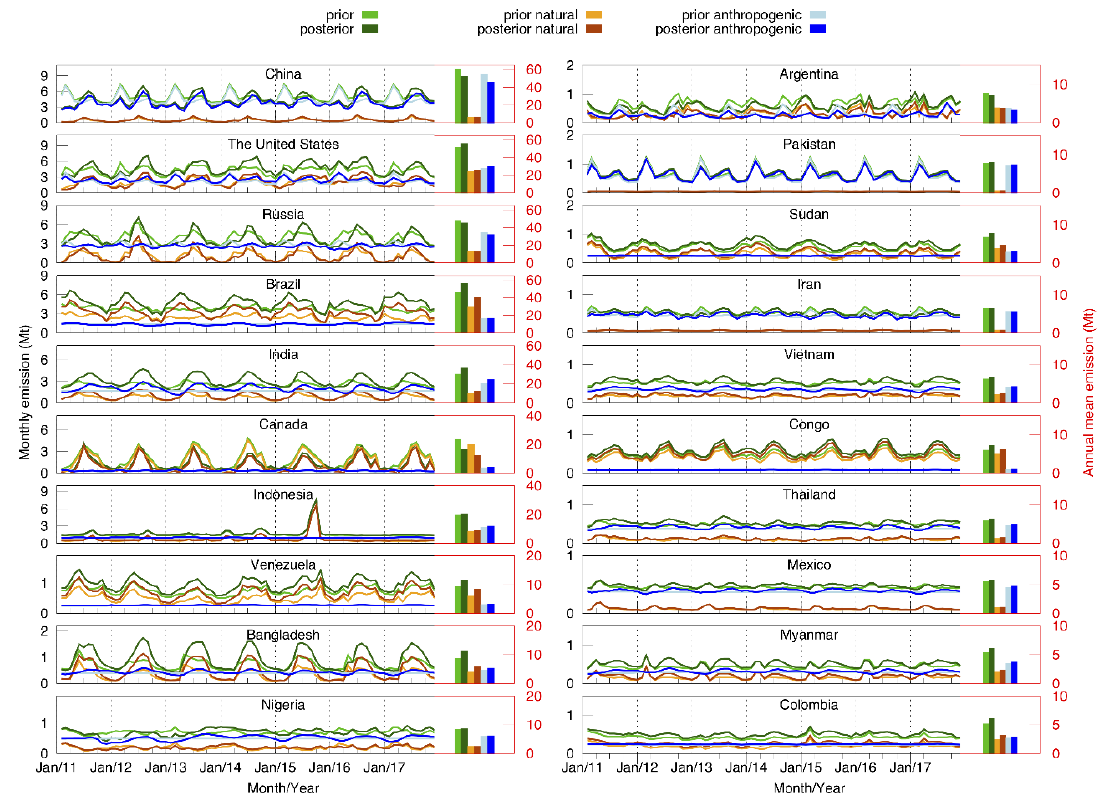
Figure 6. Time series of prior (light colors) and posterior (darker shades) fluxes for anthropogenic and natural categories and the total, for selected countries for the period from 2011 to 2017. The histograms show the mean annual total (Tg CH 4 yr − 1 ) for these categories. Units for series are on the left vertical axis, and for histograms are on the right, where the axis scales are different for each country.